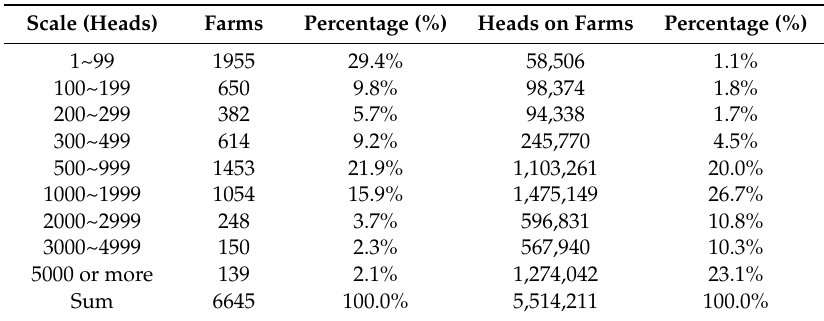
Table 1. Statistics of swine heads on farms classified by scale in Taiwan a